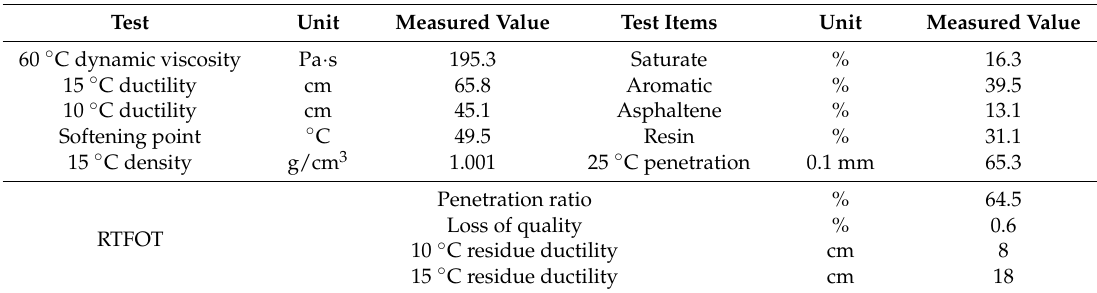
Table 2. The 70 # bitumen technical